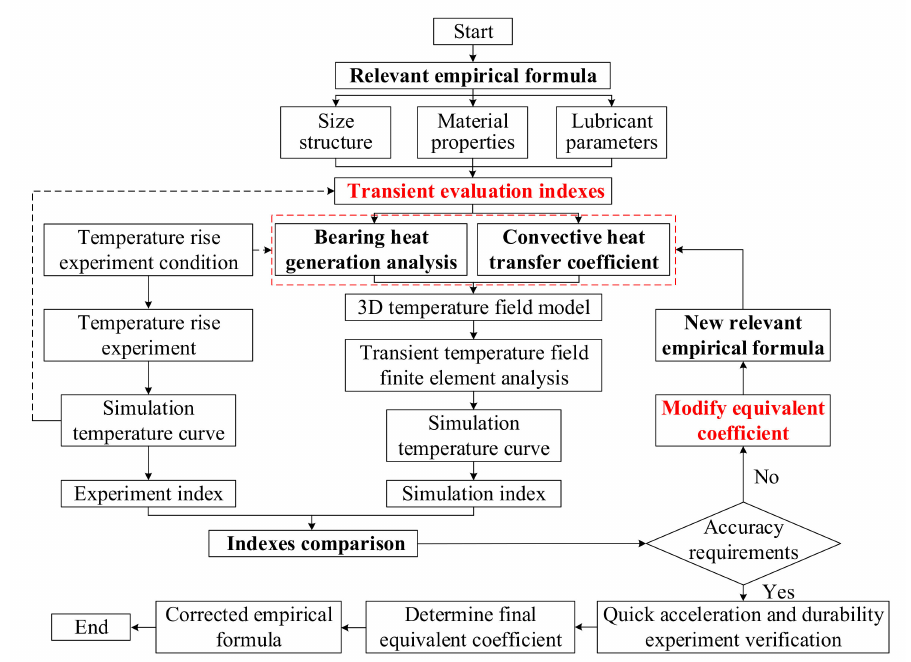
Figure 4. Correction process flow chart of the empirical